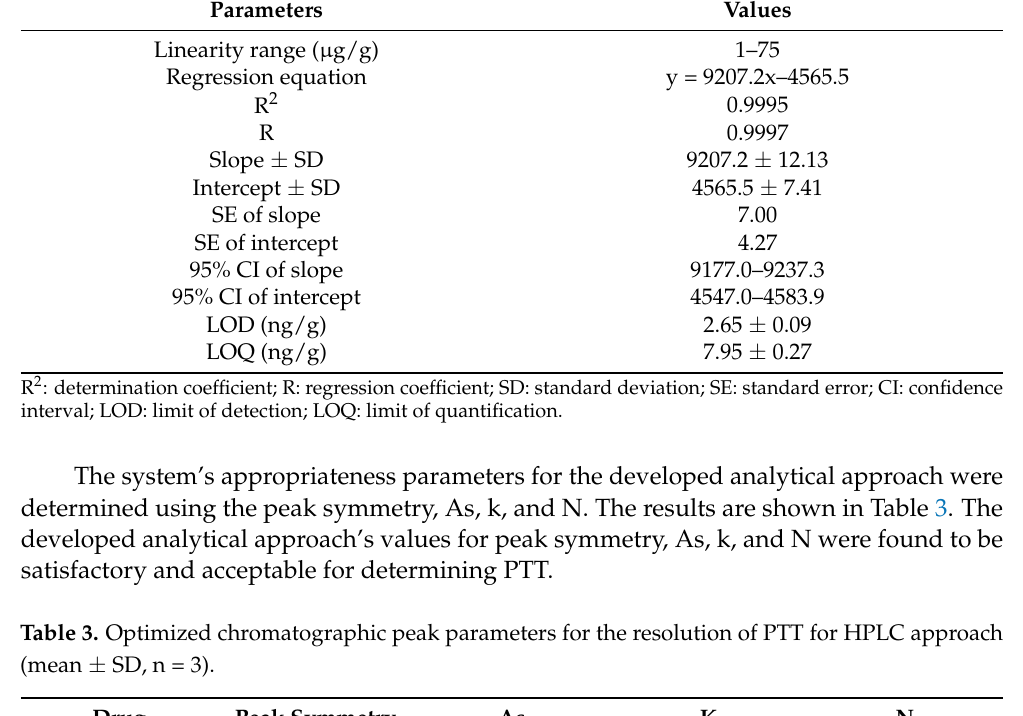
Table 2. Linear regression analysis for the calibration curve of PTT for the “high-performance liquid chromatography (HPLC)” approach (mean ± SD, n = 3). Parameters Values Linearity range ( µ g/g) 1–75 Regression equation